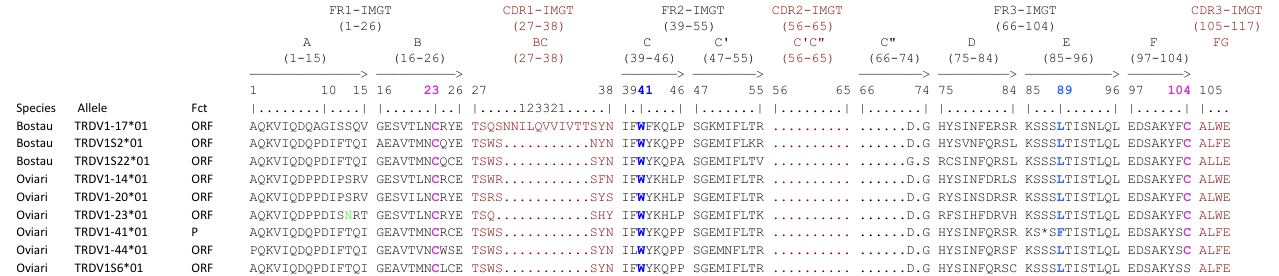
Figure 8. Protein display of the TRDV1 genes with lack of CDR2-IMGT and part of FR3-IMGT in bovine (Bostau) and sheep (Oviari). Only alleles *01 are shown. The description of the strands and loops is according to the IMGT unique numbering for V-REGION [28]. Data available in IMGT Repertoire (IG and TR) http://www.imgt.org/IMGTrepertoire/ > Proteins and alleles > Protein displays > V-REGION > TRDV > Human, ibid. Bovine, ibid.